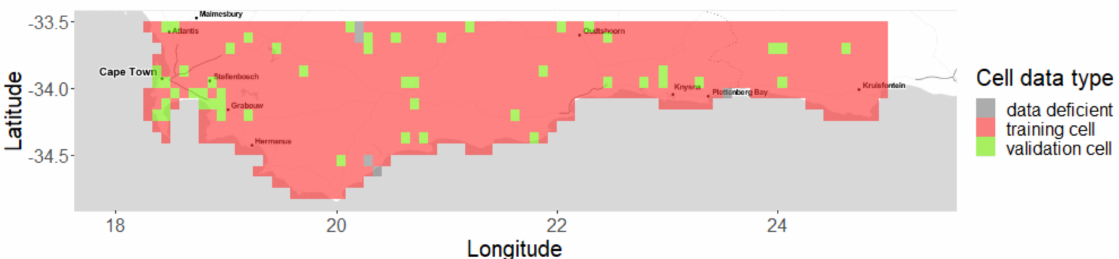
Figure A9. Study area in the Southern Cape of Africa and its rasterization into 817 square cells of approximately 10km size: 50 validation cells (light green) were drawn and, from the year 2000, their validation data were hidden from the model fitting. We then used the validation data to the test model predictions over the period 2000 to 2021. The cells containing at least one TG record whose data were fully used in the model fitting (i.e., training) are shown in red, while cells without any record are in